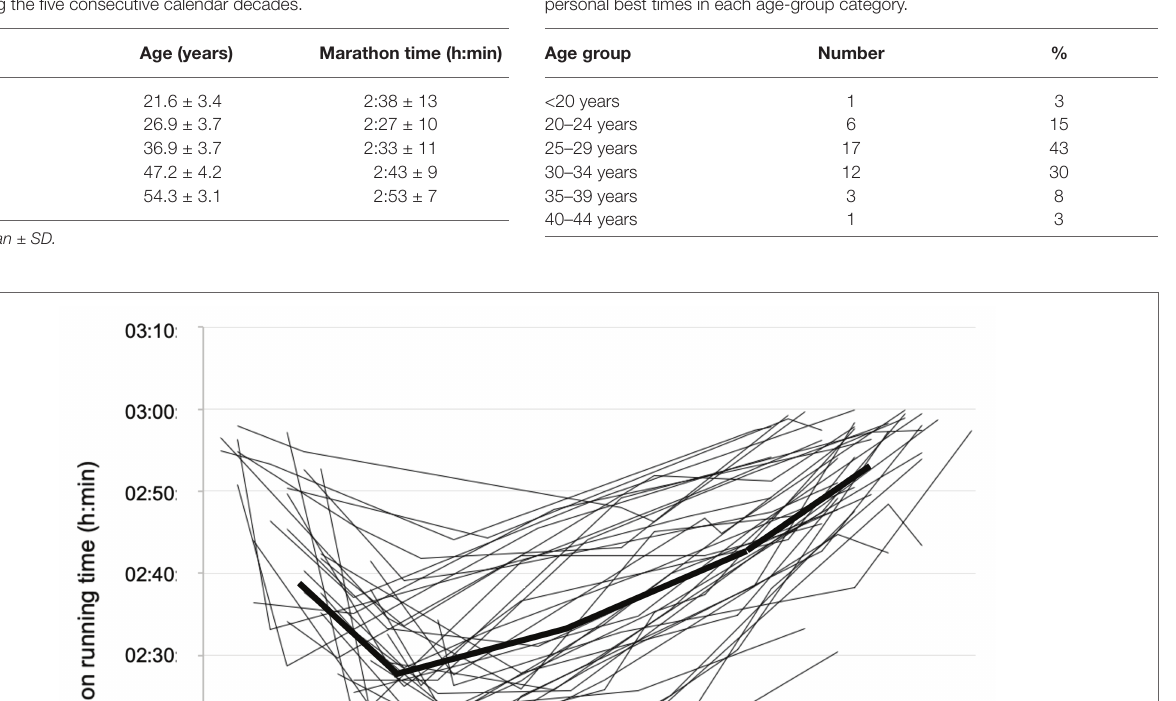
TABLE 2 | Number (and percentage of the cohort) of runners who ran their personal best times in each age-group category.